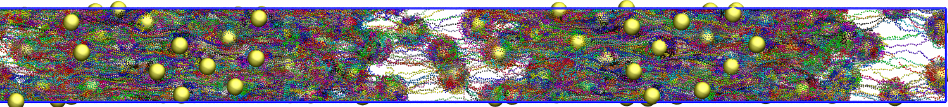
Figure 3. Snapshot taken from the S1 • system. Breaking of the unentangled IPNC system under large uniaxial extension strain (cid:101) xx = 750% at (fast) engineering extension rate of ˙ (cid:101) xx = 0.05, c.f. purple line in Figure 2b. The simulation snapshot corresponds to a system with N = 40 chains at an NP loading of φ = 11.6%, and ε r =